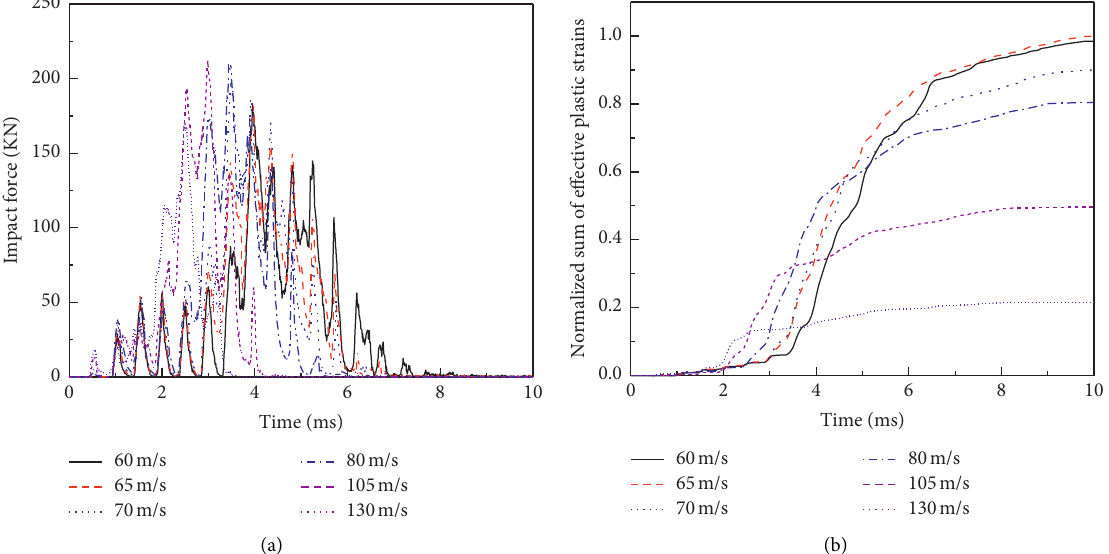
Figure 10: Effect of ingestion speed on the impact loading history and blade damage. (a) The impact loading history. (b) Normalized sum of effective plastic strains.